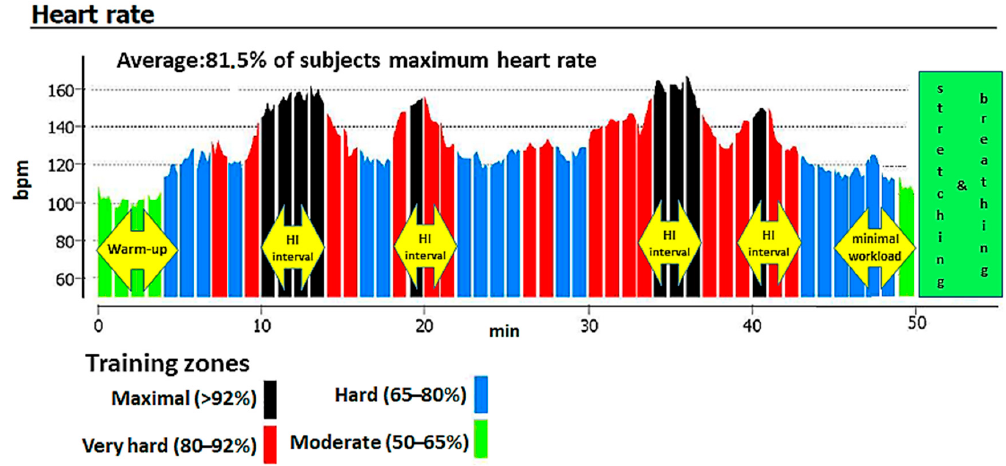
Figure 1. An example indoor cycling (IC) training session based on a heart rate graph from a Suunto Fitness Fitness Solution Solution device.